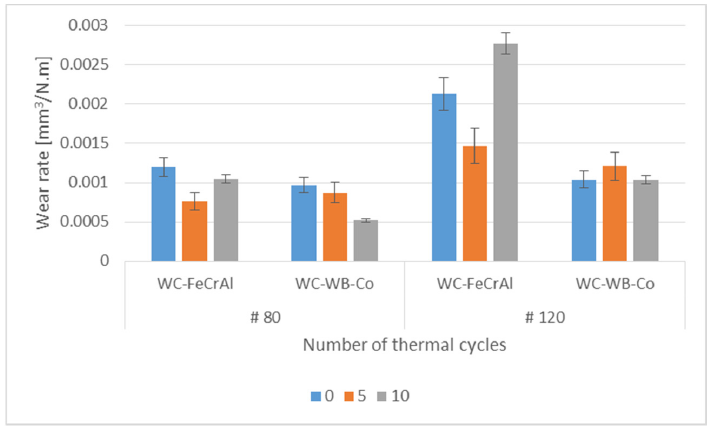
Figure 11. Wear rate of the coatings with dependence on abrasive cloth grit size.